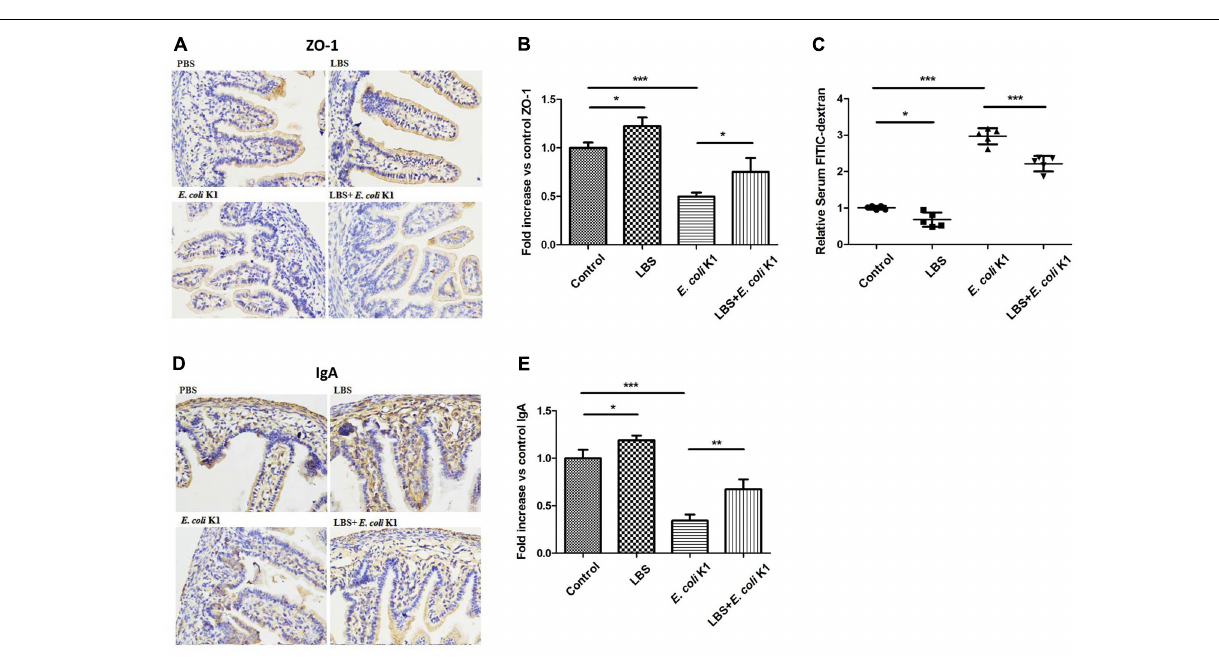
FIGURE 6 | Effects of LBS on ZO-1, IgA expressions and the permeability of neonatal intestinal tract with or without E. coli K1 infection. Two days old neonatal rats were treated as described in Figure 5 . Paraffin-embedded small intestinal tissues were prepared for ZO-1 (A) and IgA (D) staining. Images were visualized by light microscopy (400 × magnification). Semi-quantitative analysis of ZO-1 (B) and IgA (E) were performed by Image J. (C) The intestinal permeability was measured by FITIC-dextran leakage assay. The value of PBS group was assigned as 1. Data were represented as mean ± SD, n = 5. ∗ P < 0.05, ∗∗ P < 0.01, ∗∗∗ P <